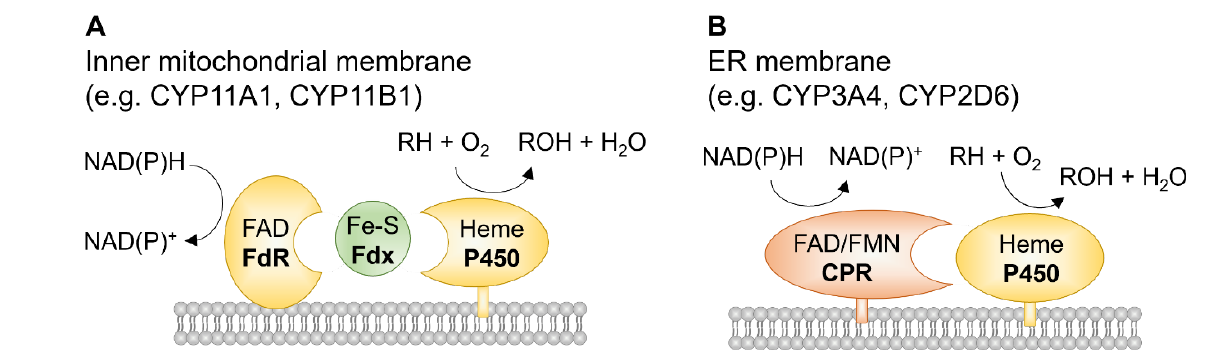
Figure 1. Two major mammalian cytochrome P450 systems with redox partner proteins. ( A ) The mitochondrial P450 systems belong to the class I system, consisting of three proteins: flavin adenine dinucleotide (FAD)-containing ferredoxin reductase (FdR), ferredoxin (Fdx/Fe-S), and P450. ( B ) class II P450 systems are most common in mammalian cells. NADPH-cytochrome P450 reductase (CPR) contains FAD and flavin mononucleotide (FMN) as prosthetic groups. Adapted from [8] .